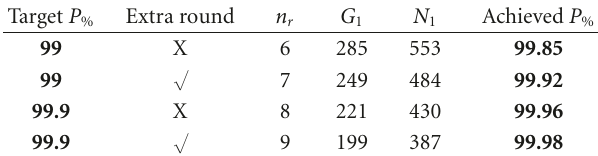
Figure 11: Trend for the average tag identification time, when the first round frame size is varied. Table 3: Performance results: m -ASAP with tag count